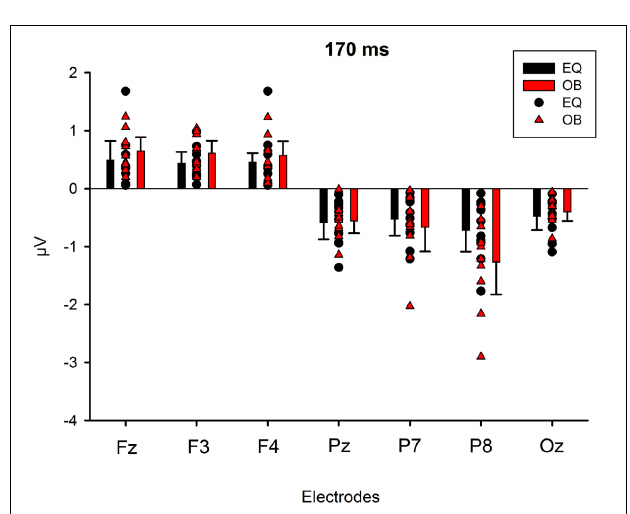
FIGURE 10 | Mean amplitude values ( µ V) and confidence intervals, and scatterplots of the individual participants’ values for each electrode in the equiprobable condition (EQ) and oddball condition (OB) for the 170-ms component (differential response; emotional minus neutral face). No significant differences between conditions were